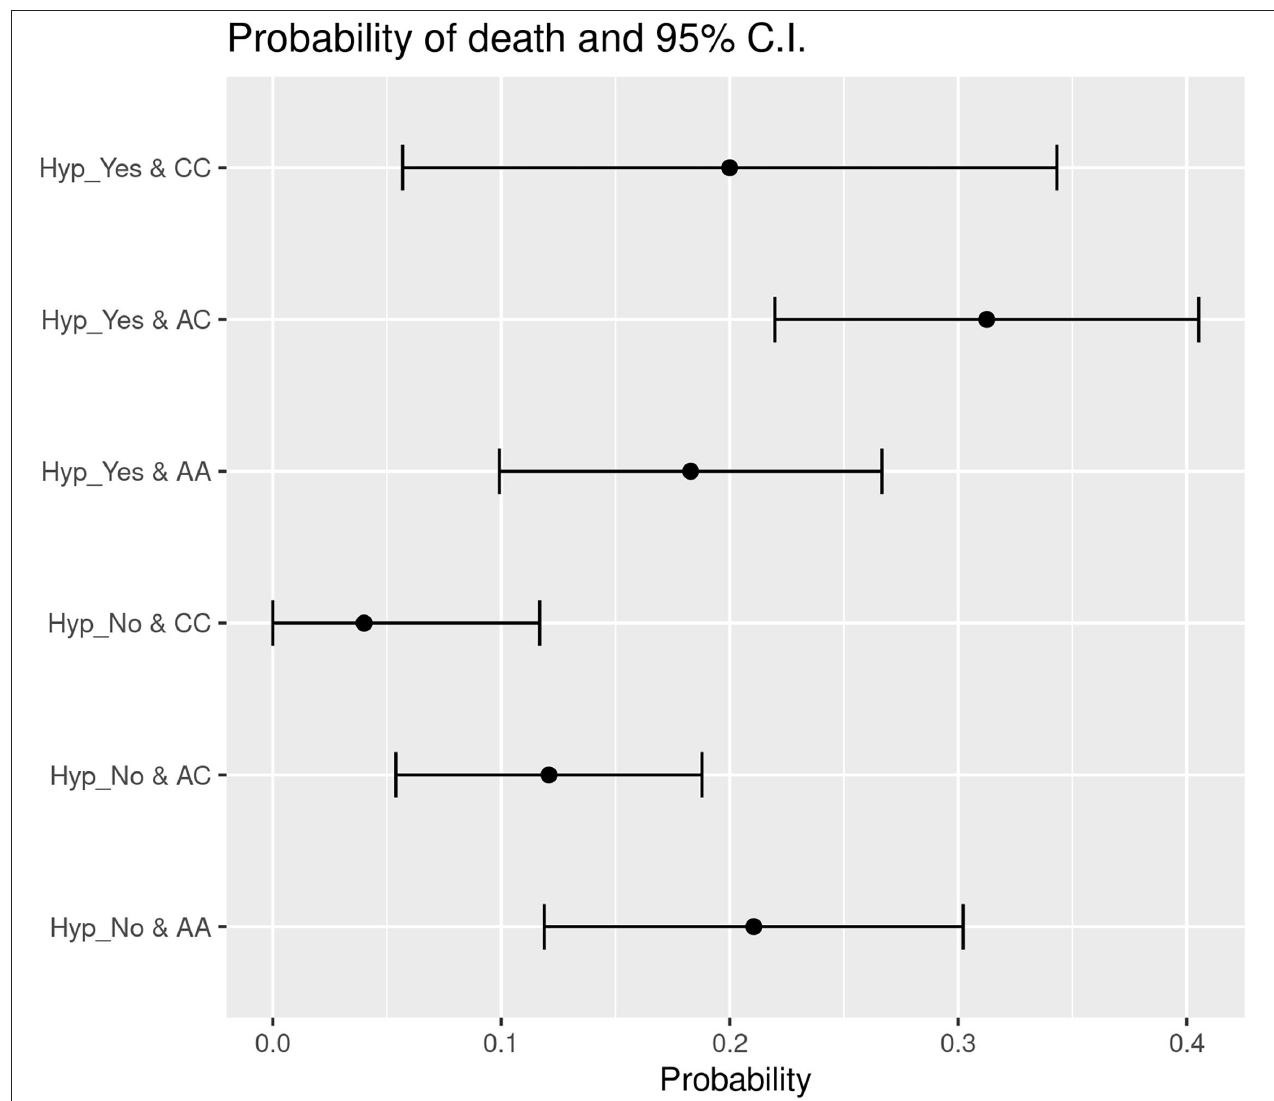
FIGURE 2 | Probability of death subdivided based on the presence of hypertension in the different HSD3B1 polymorphism variants. In both P1245A > C and P1245C variants, the presence of hypertension increases the probability of decease; instead, P1245A cases present the opposite trend. P1245C is the one with higher increment, showing an increase of 5 times in the presence of hypertension. AA, P1245A polymorphic variant; AC, P1245A > C polymorphic variant; CC, P1245C polymorphic variant; CI, confidence interval; Hyp_Yes, the presence of hypertension; Hyp_No, the absence of